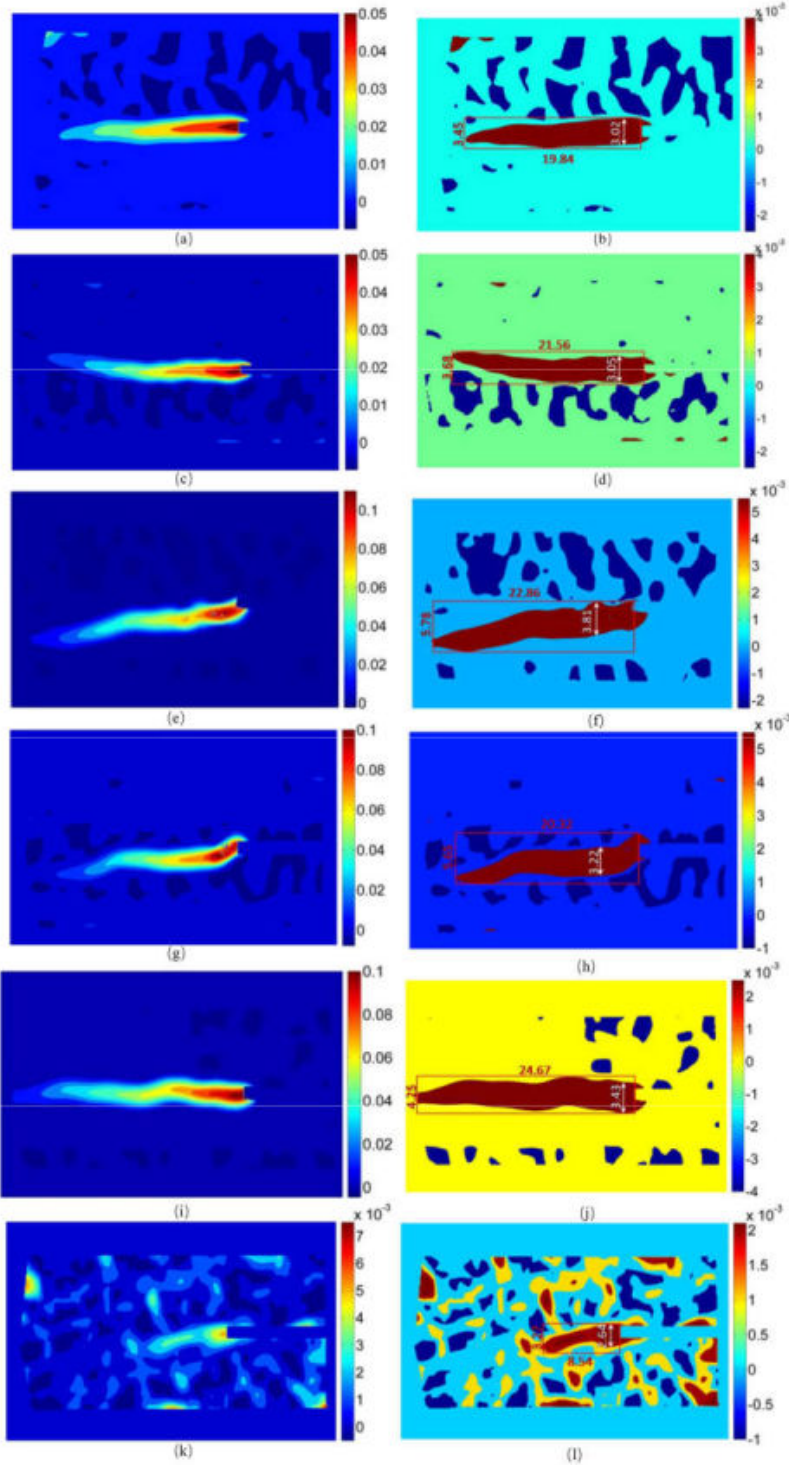
Figure 17. Maximum principal strain distribution and FPZ of the NSCB specimen before the frac- ture: ( a ) distribution diagram for the splitter fracture (specimen S1); ( b ) splitter FPZ (specimen S1); ( c ) distribution diagram for the shale splitter fracture (specimen S2); ( d ) splitter FPZ (specimen S2); ( e ) distribution map for the shale arrester fracture (specimen A1); ( f ) arrester FPZ (specimen A1); ( g ) distribution map for the shale arrester fracture (specimen A2); ( h ) arrester FPZ (specimen A2); ( i ) distribution map for the shale divider fracture (specimen D1); ( j ) divider FPZ (specimen D1); ( k ) distribution map for the shale divider fracture (specimen D2); ( l ) divider FPZ (specimen